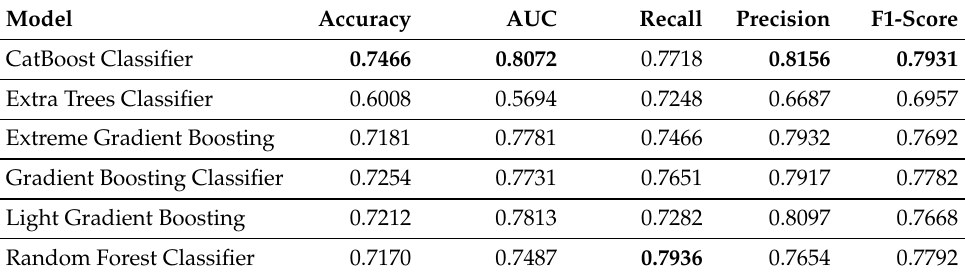
Table 7. Split by patient test set results (best scores in